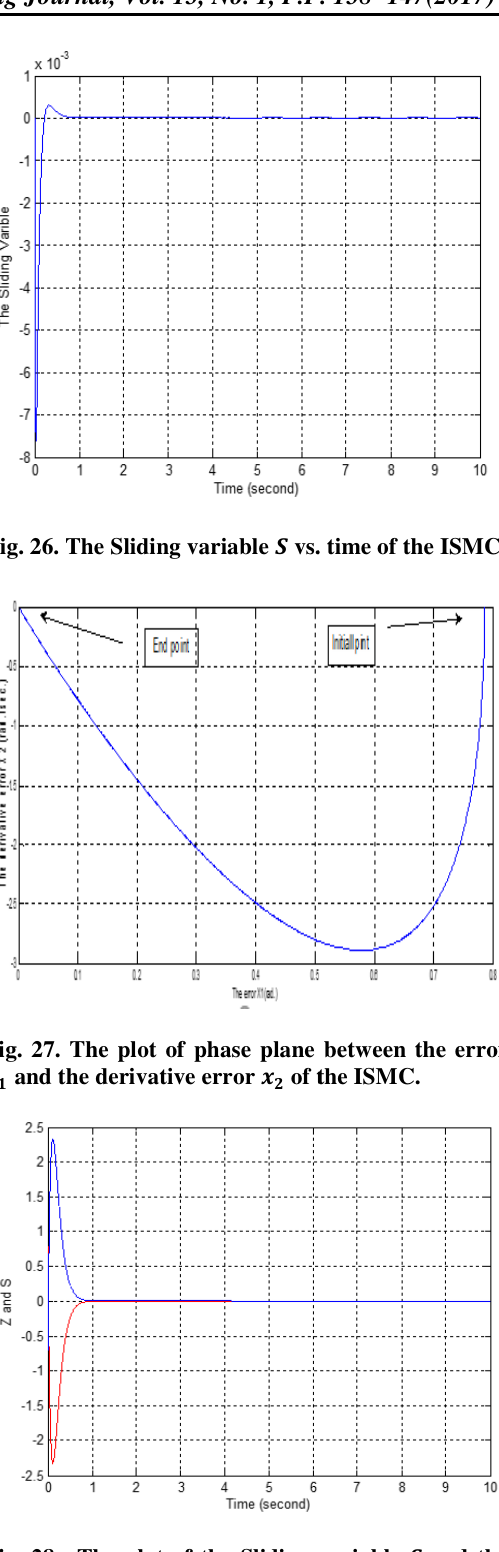
Fig. 25. The control action c vs. time of the ISMC.